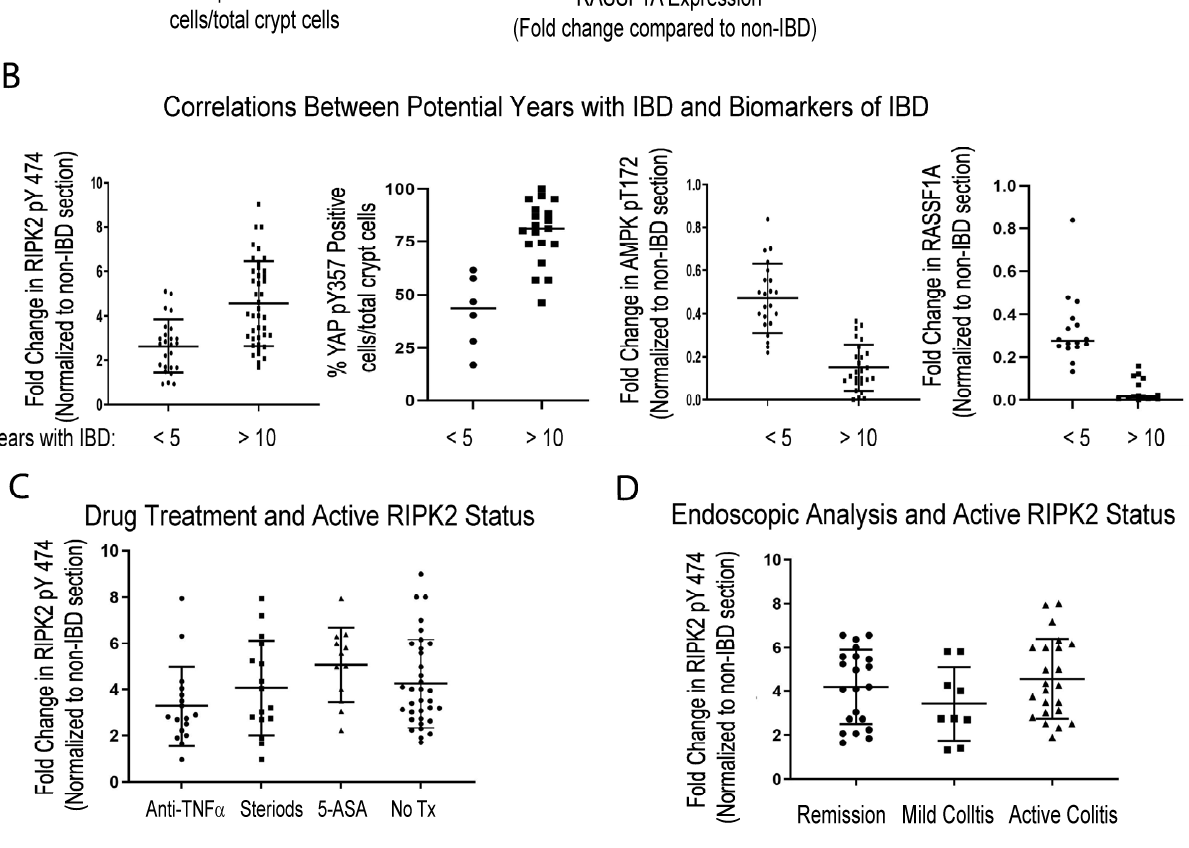
Figure 5. Potential correlations between four identified biomarkers of IBD—RASSF1A, (AMPK α 1), YAP, and RIPK2. ( A ) Correlations between biomarkers. For top left, r 2 = 0.07 and p value 0.05, n = 60–74; top middle panel, r 2 = 0.70 and p value < 0.0001, n = 45–50; top right, r 2 = 0.60 and p value < 0.001, n = 55–60; bo tt om left, r 2 = 0.33 and p value 0.0001, n = 45–60; bo tt om right, r 2 = 0.10 and p value 0.022, n = 60. ( B ) Correlations between biomarkers and duration of disease. For ( B ), p value < 0.001 for all comparisons explored (n = 30–40 for RIPK and (AMPKa1); n = 15–20 for YAP and RASSF1A analysis). ( C ) Correlations between active RIPK2 pY474 and therapy, before biomarker was estab- lished. For ( C ), p value > 0.05 for all treatments, compared to No Tx and n = 12–17 patients per drug group and 40 for the No Tx group (all patients with disease for more than 10 years). ( D ) Correlations between active RIPK2 pY474 and histologic staining of tissues during clinical management. For ( D ), p value > 0.05 for comparing RIPK2 pY474 fold change in patients during remission, when compared to patients with moderate to active disease (n = 10–23 in each category and most patients with dis- ease for more than 10 years).